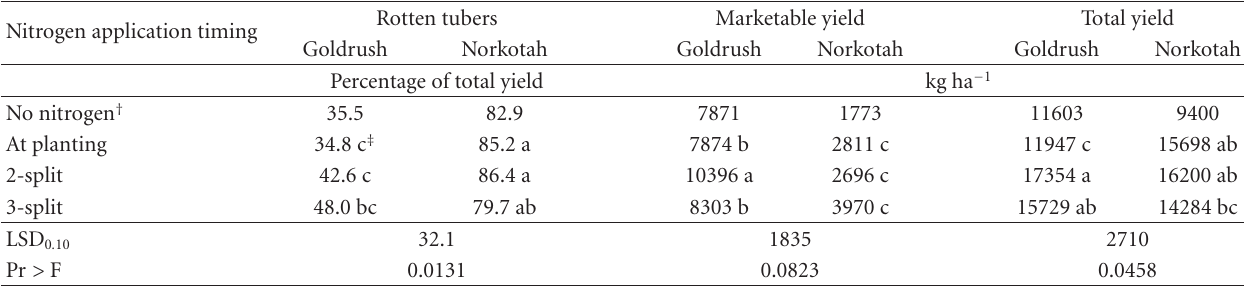
Table 9: Nitrogen application timing × variety interaction in 2011 for rotten tubers as a percentage of total yield, marketable tuber yield, and total tuber yield for Russet potatoes grown on sandy loam soils in the Mid-Atlantic, averaged across N